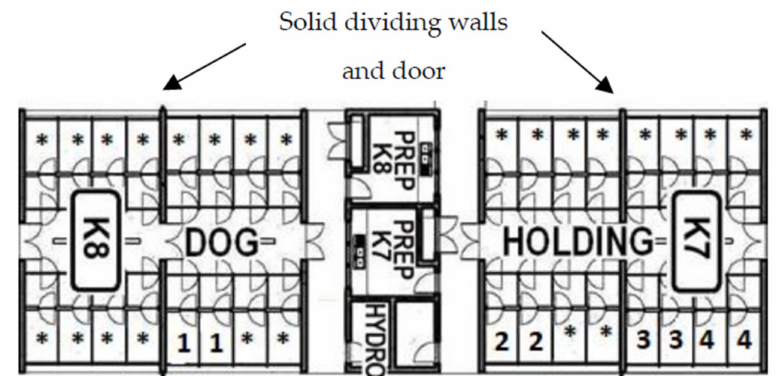
Figure 1. Kennels used for the measurement of the behaviour of dogs ( n = 60) exposed to, Music, DAP, Lavender stimuli or a Control. K7 and K8 were the two blocks of dog kennels used for the study. 1: kennels for the Lavender treatment; 2: kennels for the Music treatment (separated from the other treatments by solid dividing walls); 3: kennels for the Control treatment; 4: kennels for the DAP treatment; *: kennels not holding a study